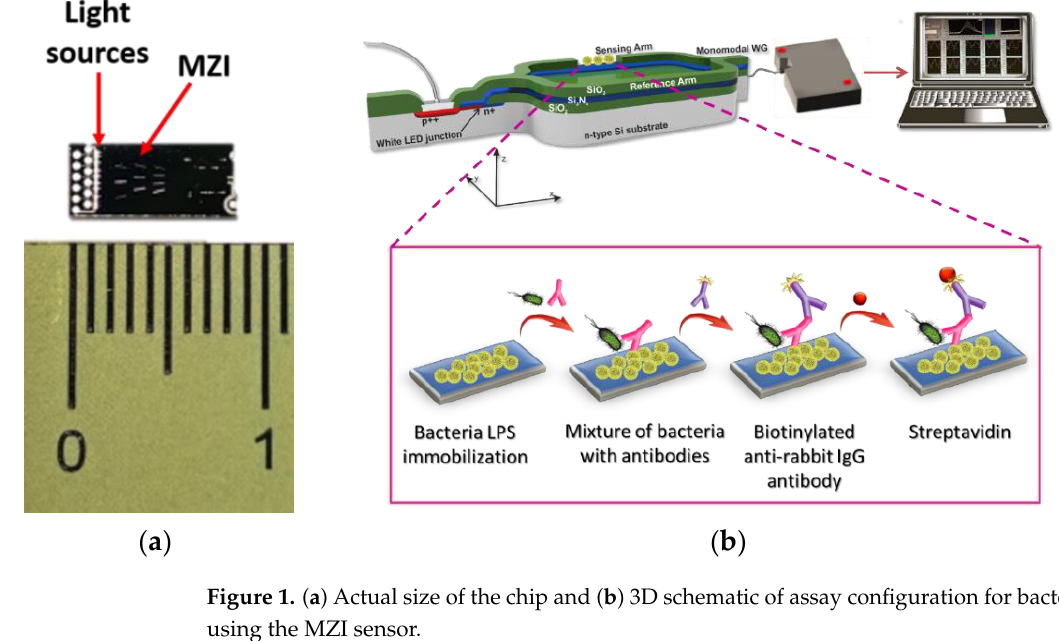
Figure 1. ( a ) Actual size of the chip and ( b ) 3D schematic of assay configuration for bacteria detection using the MZI sensor.